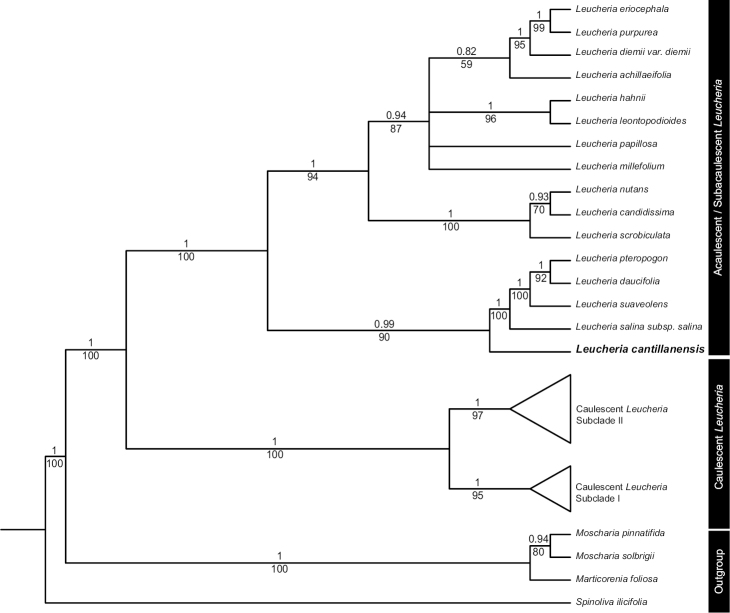
Phylogeny of Leucheria resulting from Bayesian analysis of the combined nuclear ITS and plastid rpl32-trnL and trnL-trnF dataset. Numbers above and below the branches represent the Posterior probabilities from the BI analysis and bootstrap values from the ML analysis, respectively. Nodes with <0.5 PP were collapsed to polytomies. The new species, Leucheria
cantillanensis is highlighted in bold.